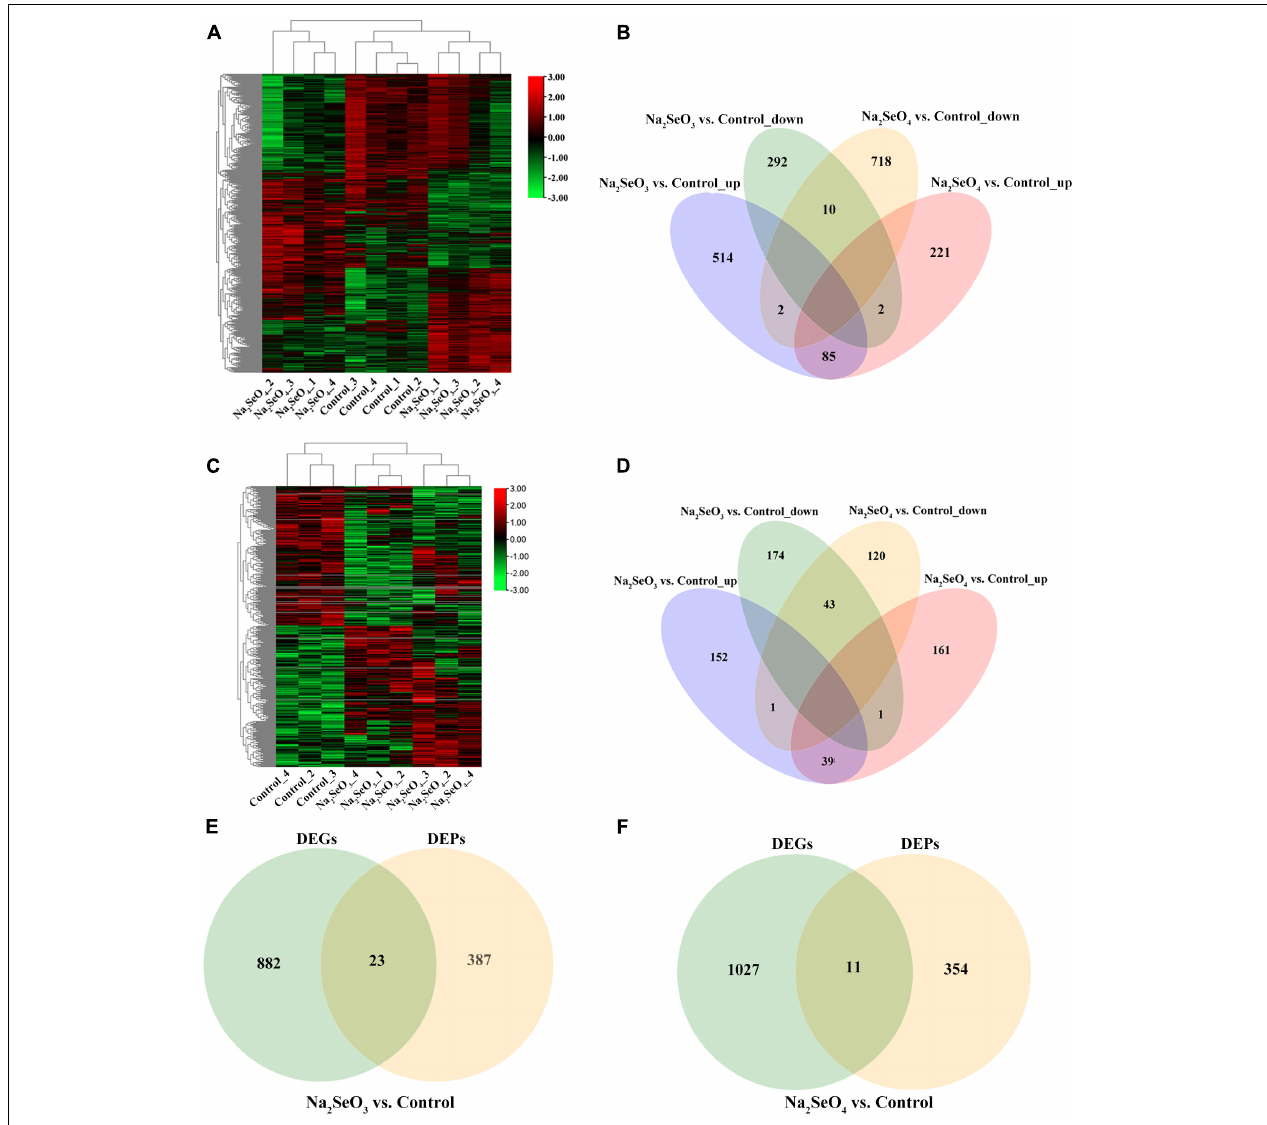
FIGURE 2 | Heatmap and Venn diagram analyses of differentially expressed genes (DEGs) and differentially expressed proteins (DEPs) in response to selenite and selenate treatments. (A) DEG heatmap. (B) Venn diagram showing overlap in numbers of upregulated and downregulated DEGs between Na 2 SeO 3 vs. control and Na 2 SeO 4 vs. control. (C) DEP heatmap. (D) Venn diagram showing overlap in numbers of upregulated and downregulated DEPs between Na 2 SeO 3 vs. control and Na 2 SeO 4 vs. control. (E,F) Venn diagram showing overlap in numbers of DEGs and DEPs for Na 2 SeO 3 vs. control and for Na 2 SeO 4 vs. control,